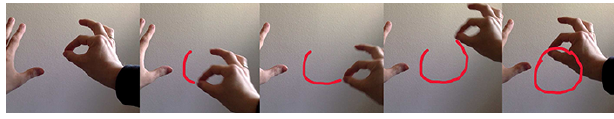
Figure 9. Demonstration of drawing a sphere gesture in mid-air using the starting gesture